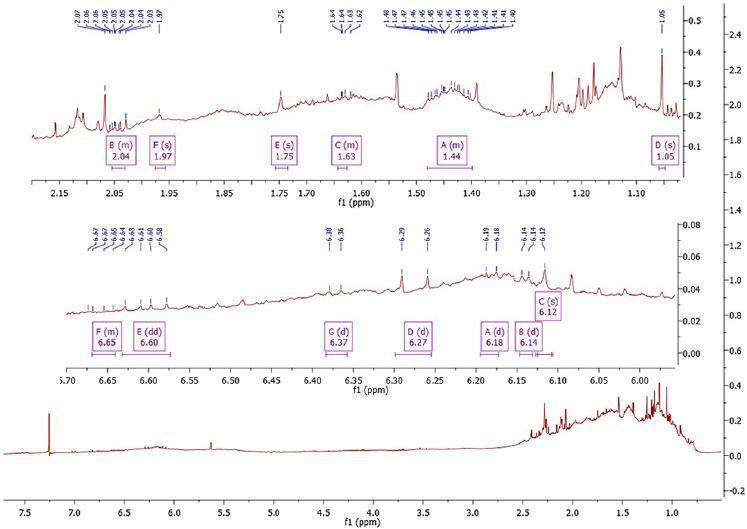
Fig 3. The 1 H NMR spectrum of β -carotene isolated from S . obliquus microalgae. (500 MHz, CDCl 3 ).